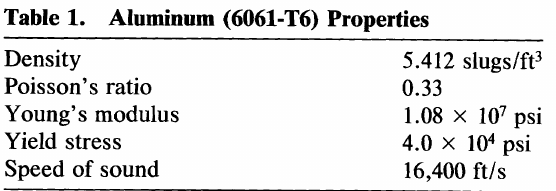
Table 1. Aluminum (6061-T6) Properties